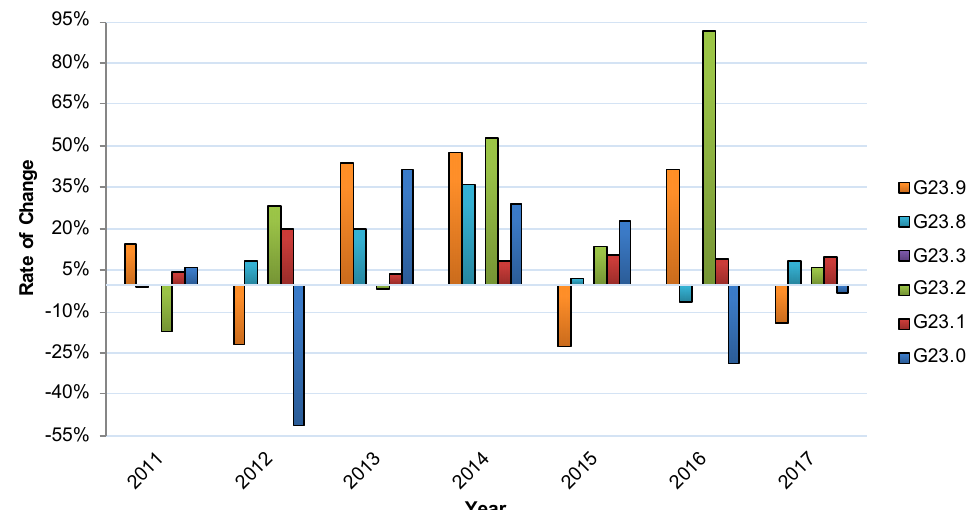
Figure 2. Relative annual changes in inpatient treatment for disease subgroups between 2010 and 2017. G23.0: Neurodegeneration with Brain Iron Accumulation, G23.1: Steele—Richardson—Olzewski syndrome (PSP), G23.2: Multiple system atrophy of parkinsonian type (MSA-P), G23.3: Multiple system atrophy of cerebellar type (MSA-C), G23.8: Other specified degenerative diseases of the basal ganglia, G23.9: Other degenerative diseases of the basal ganglia, not further defined.